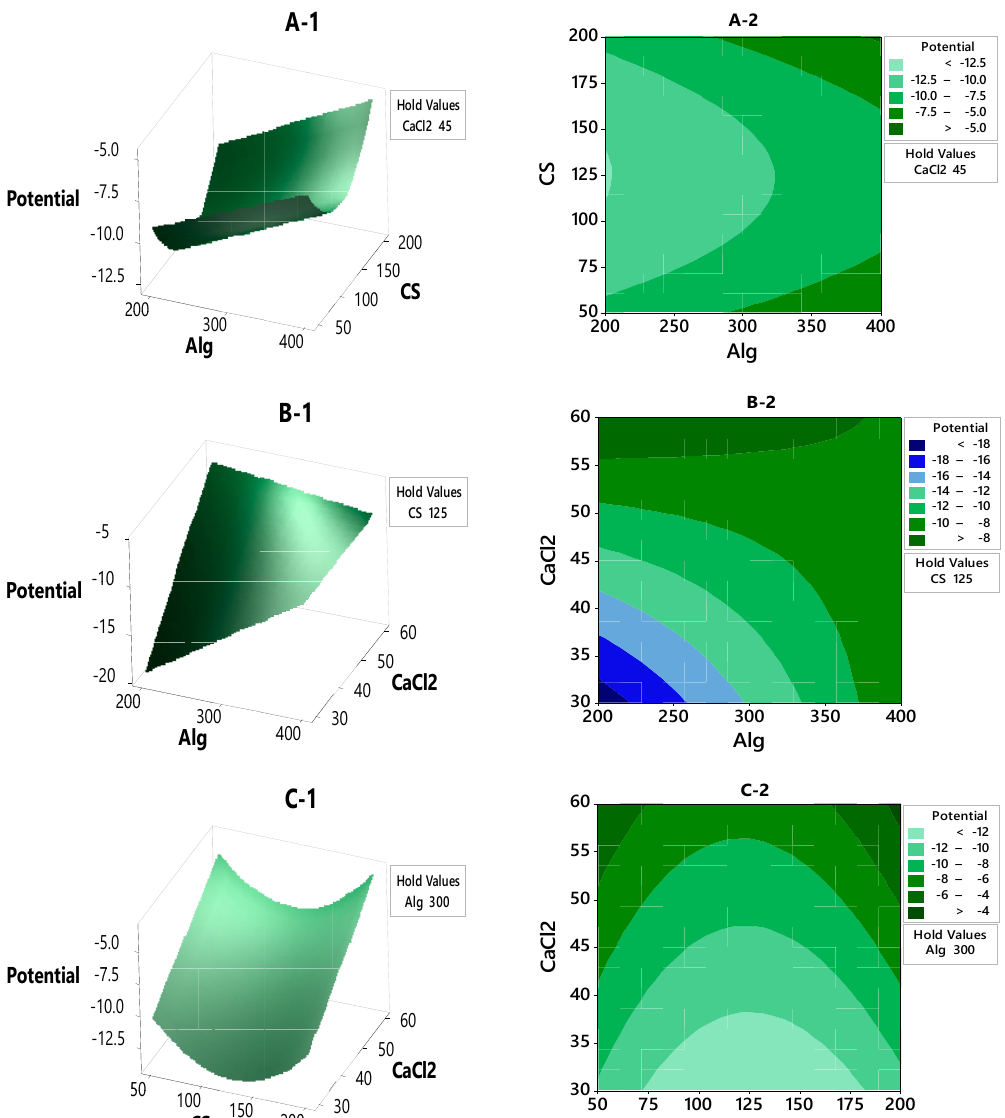
Figure 4. The contour plot and response surface of the zeta potential with variances of CaCl 2 , Alg and 274 CS concentrations. 275